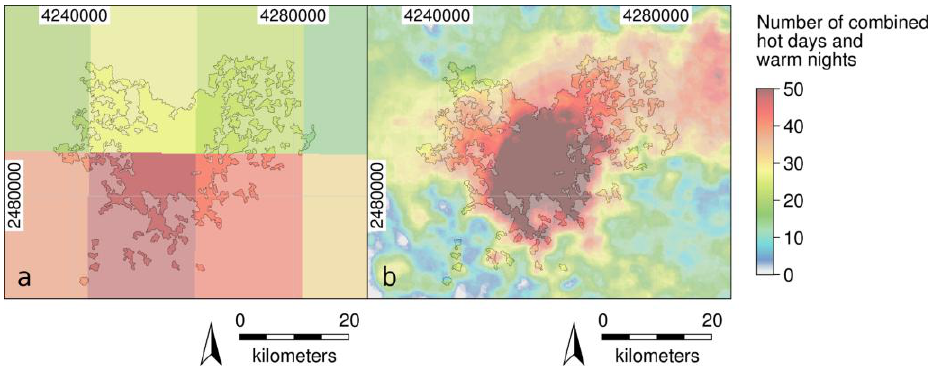
Figure 7. The number of combined hot days and warm nights in 2003. The black line delineates the Italian city of Milano. ( a ) Currently used by the European Environmental Agency (EEA; after [35]); ( b ) the equivalent based on MODIS LST. The delineation of Milano, covering about 1,300 km 2 , is together, with (a), available on the EEA website. All data are in Lambert azimuthal equal area projection (EPSG code: 3035). The extents in geographical degrees of (a) and (b) are approximately 45°44′41′′N, 8°47′49′′E, 45°15′23′′N,